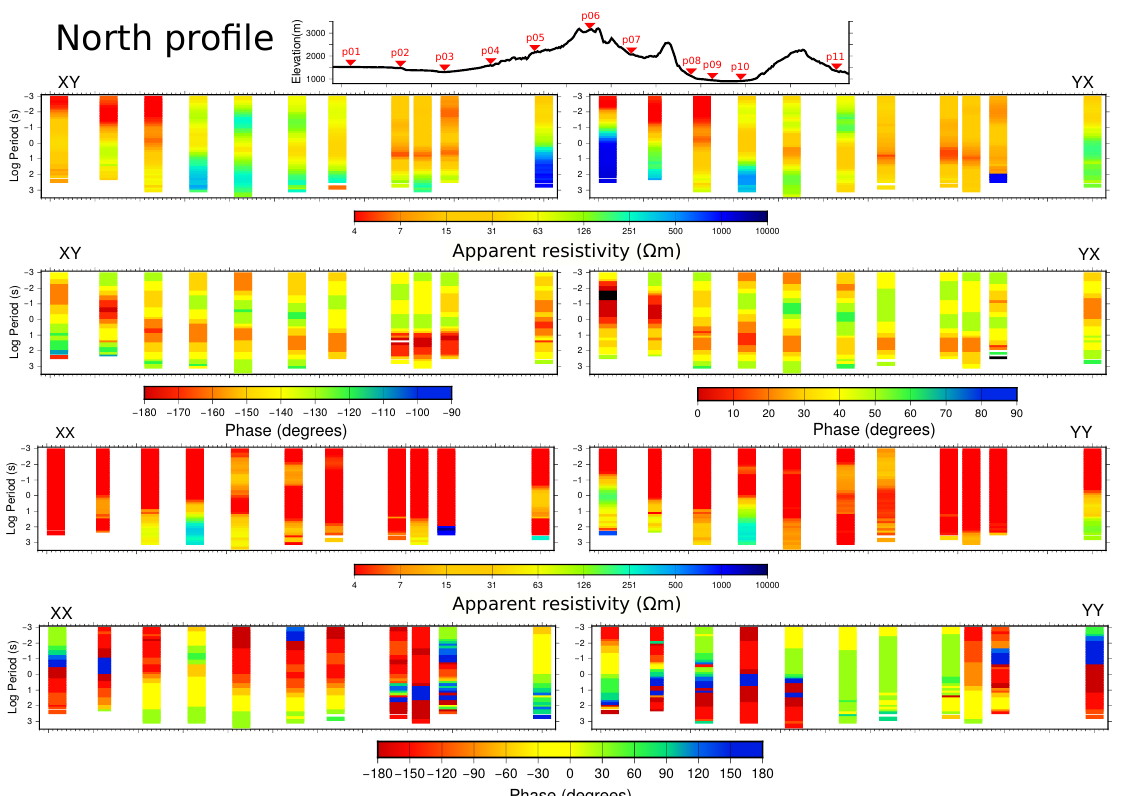
Figure A1. Northern profile (p01–p11): cross sections of apparent resistivity and phase for the four components of the impedance tensor for all